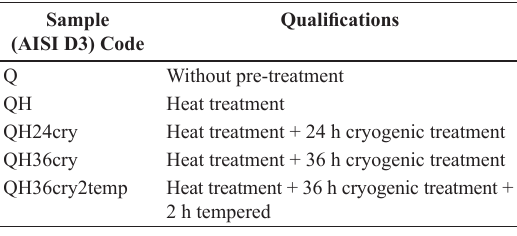
Table 2. Investigated AISI D3 steel sample codes and qualifications. Sample (AISI D3) Code